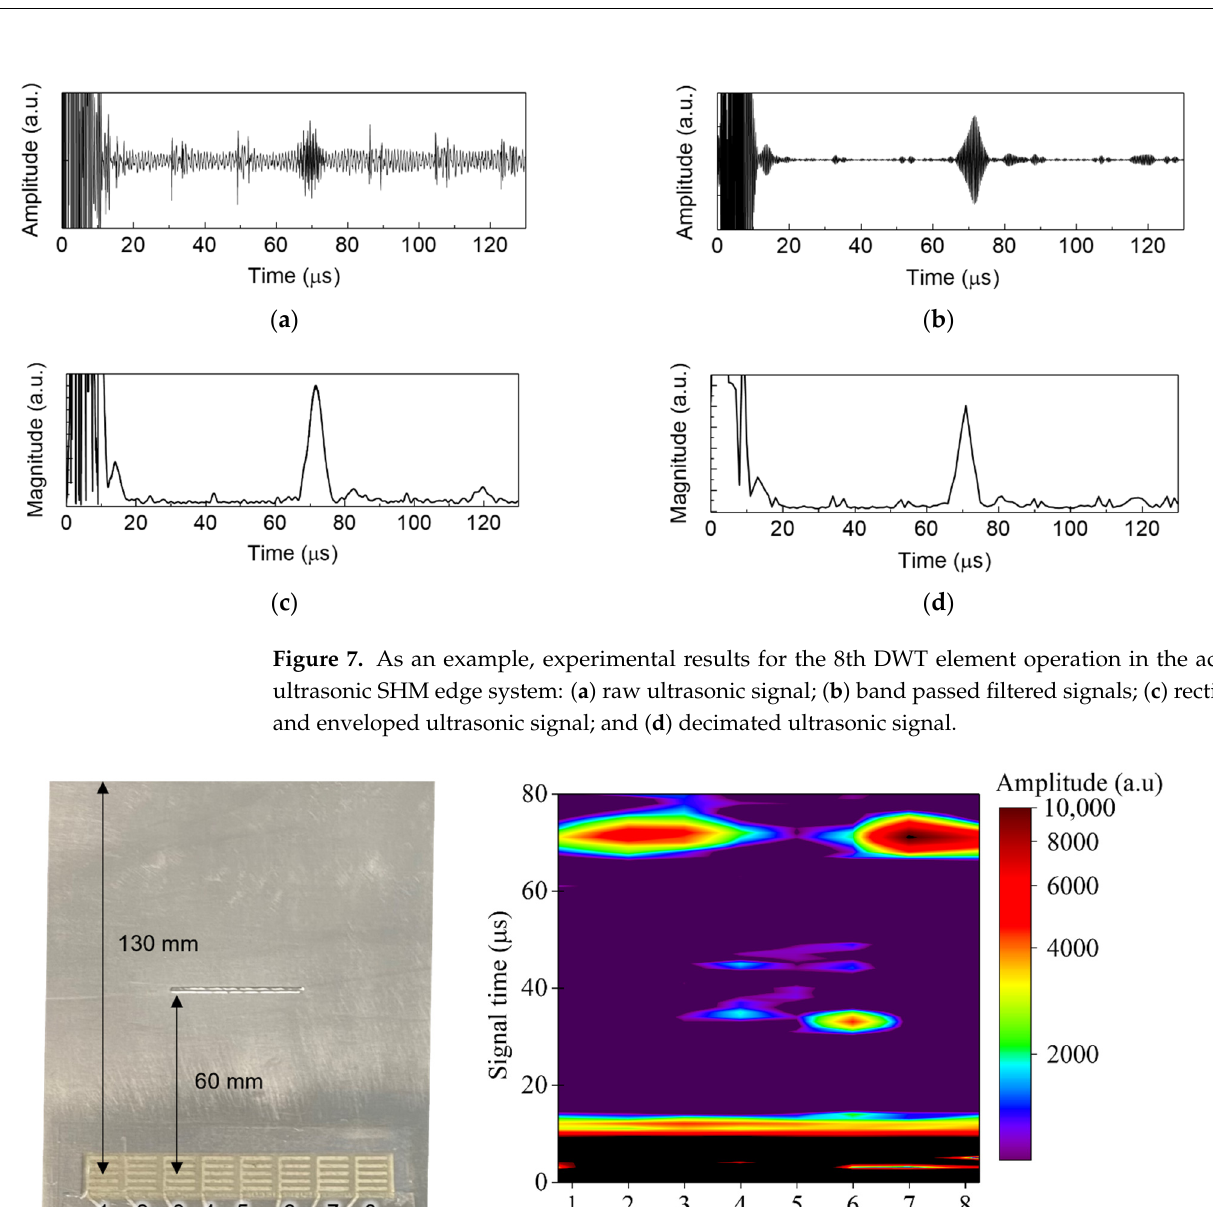
Table 1. Comparison of energy savings in the wireless module with and without edge-computing for a complete sequential scan routine.